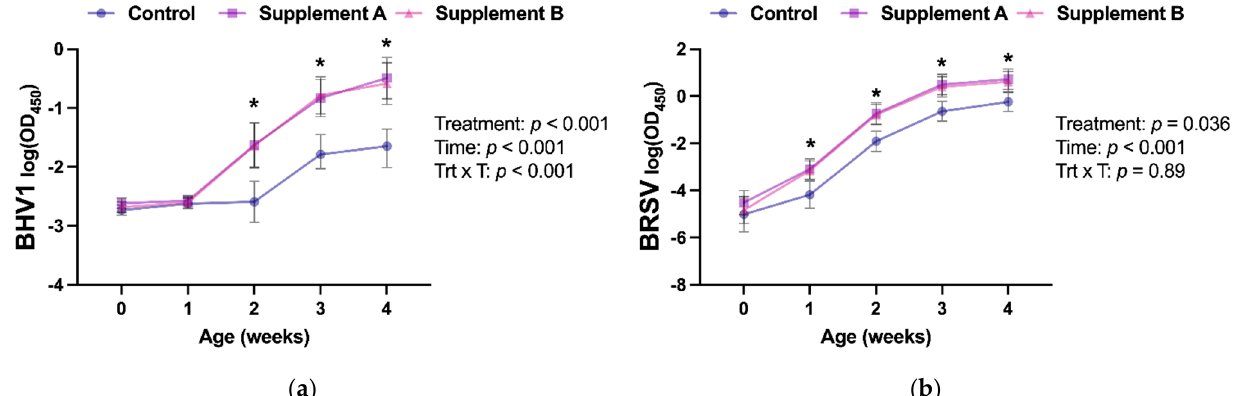
Figure 2. Immunoglobulin A responses in nasal secretions throughout the first 4 weeks of age against ( a ) Bovine Herpesvirus- 1 (BHV1) and ( b ) Bovine Respiratory Syncytial Virus (BRSV). Antigen-specific immunoglobulin A was measured using an ELISA assay, and results were analyzed using mixed models with repeated measures, including the main effects of treatment (control, supplement A, or supplement B), time (weeks of age), and the treatment x time interaction (Trt x T). Week 0 samples were collected prior to administration of a commercial intranasal vaccine. Results are presented as least squares means and 95% confidence intervals of the logarithm of the optical density at 450nm (OD 450 ). OD 450 readings are proportional to the amount of immunoglobulin A in the sample. * denotes differences ( p < 0.05) between the control and the supplement groups at a given age point as reported by Tukey’s honest significance